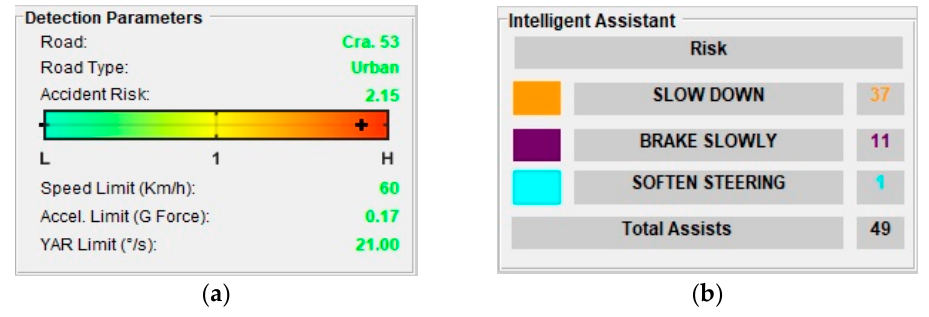
Figure 11. Route 2: ( a ) Assessment parameters, ( b ) Assistance results.